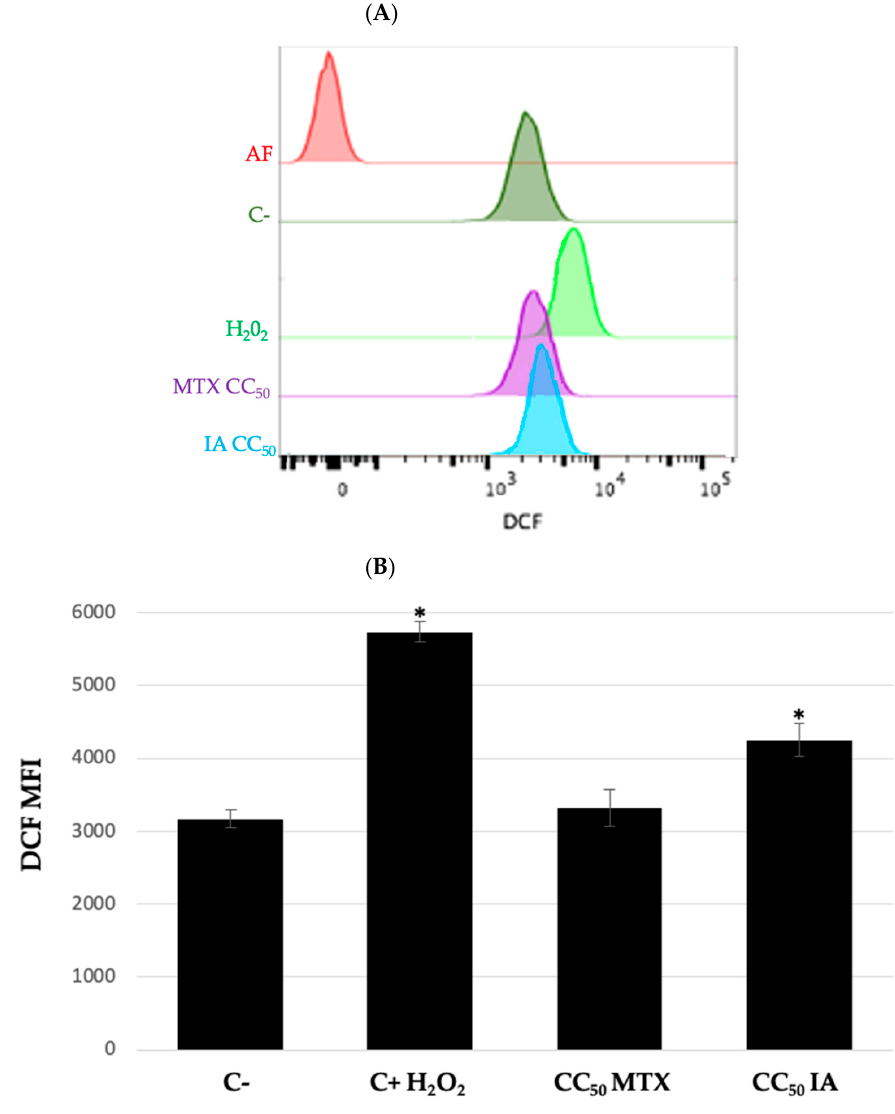
Figure 3. Production of ROS. Quantification was performed by luminescence using DCF reagent. Incomptine A ( IA ) increases oxygen reactive species in U-937 cells. ( A ) Representative histogram from evaluated treatments. Fluorescence peak of DCF moves towards the right depending on DCF oxidation by increasing intracellular reactive oxygen species, positive control H 2 O 2 showed the maximum shift of fluorescence peak. ( B ) DCF index was calculated, respectively, to negative control, finding significant differences in positive control H 2 O 2 and incomptine A treatments. Data is expressed as means ± SEM, n = 3; * p < 0.05. MTX, methotrexate; IA, incomptine A; DCF, dichlorofluorescein 2 ′ ,7 ′ -diacetate.